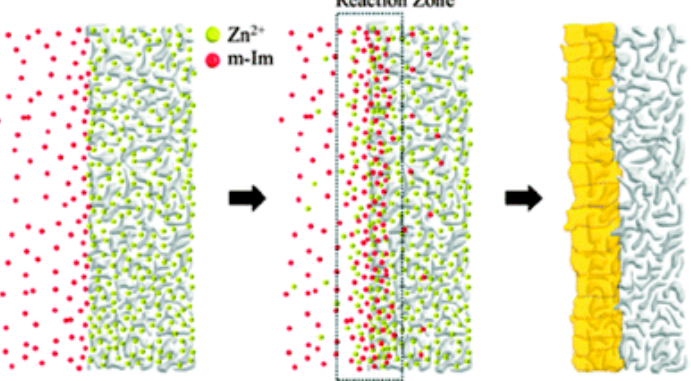
Figure 10. Schematic illustration of membrane synthesis using the counter-diffusion-based in situ method (adapted with permission from ref. [69]).